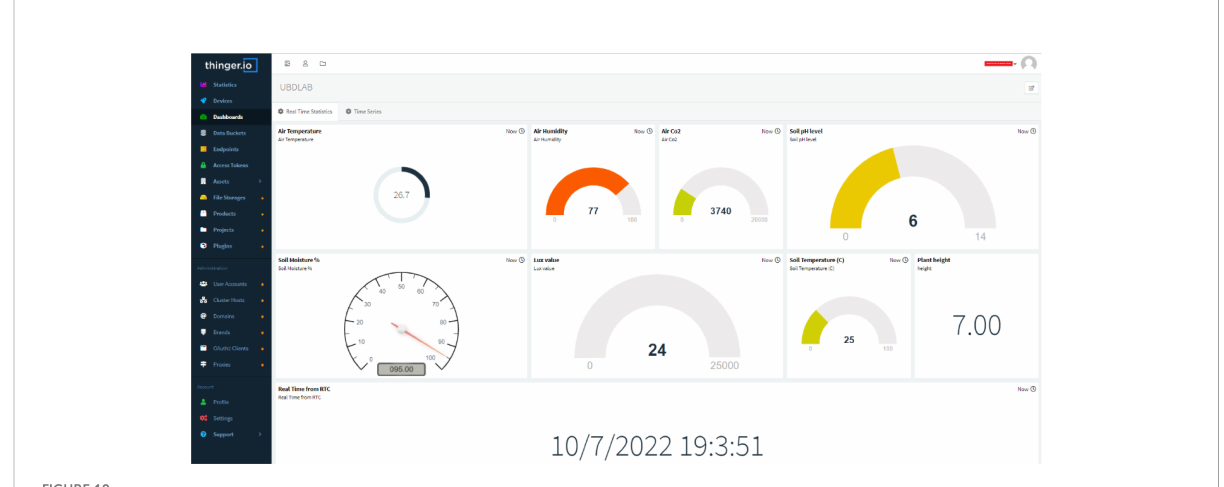
FIGURE 10 Cloud dashboard made for data visualization and actuator control in Thinger.io.